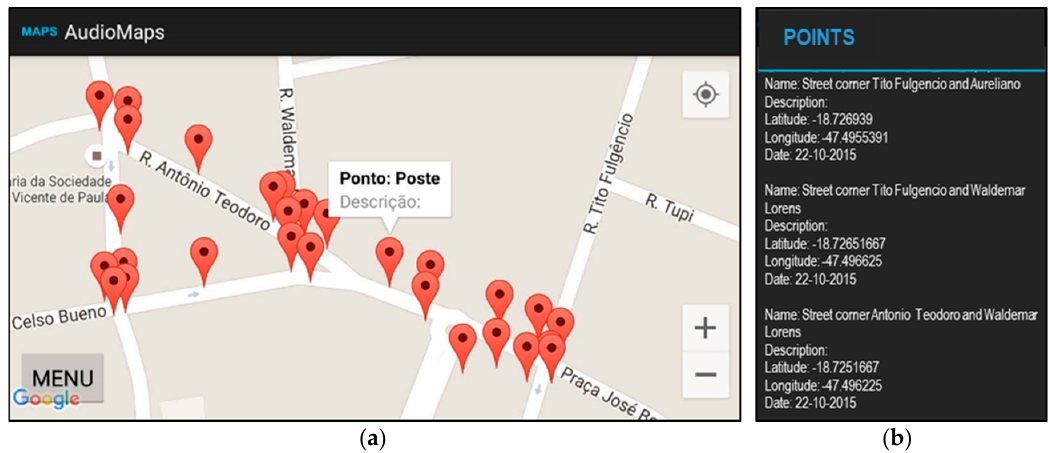
Figure 3. ( a ) AudioMaps interface with collected and described points; ( b ) description of the collected points, e.g., street corners.